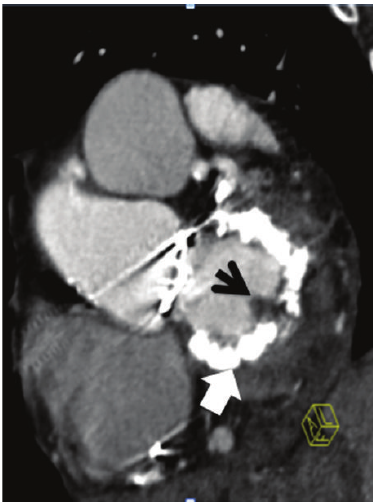
Figure 4: Mitral annulus ring calcification (MAC) hyperintense (big white arrow) . This patient also had infective endocarditis; therefore, a mitral valve vegetation —hypodense-black (round, mass like) left- sided (black arrow) was found, attached to the calcified mitral ring. Short axis view of the mitral valve.